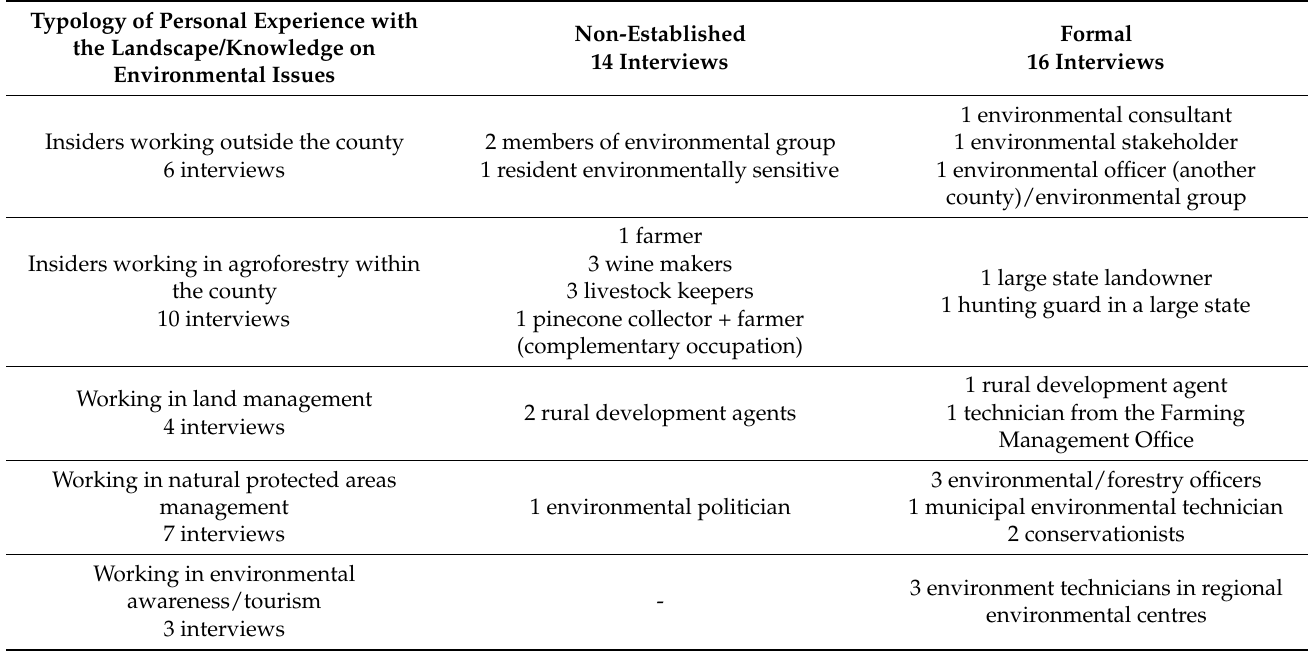
Table 1. Population survey selection (30 stakeholders in